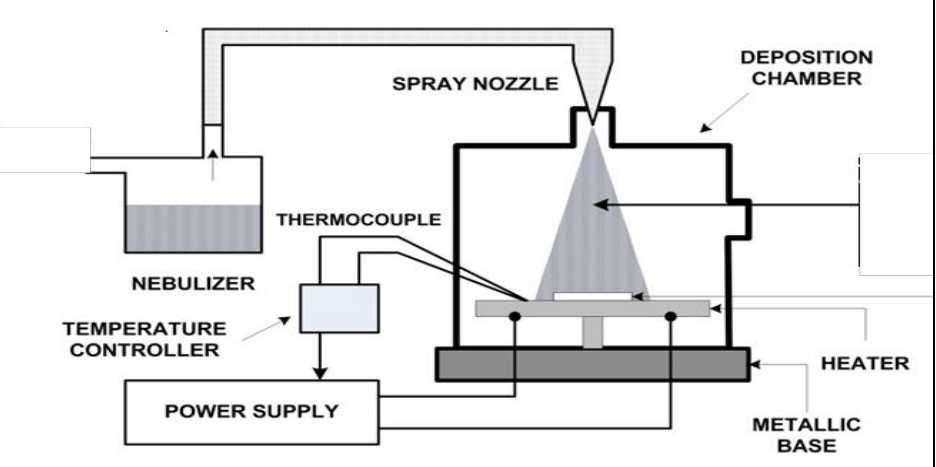
Figure 1: Schematic diagram for system set